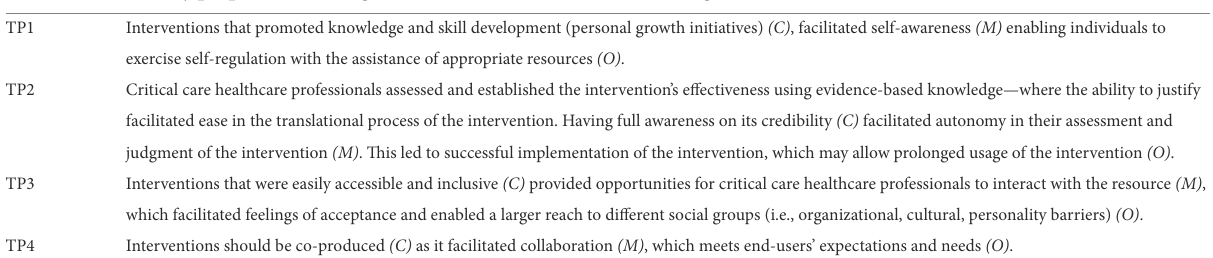
TABLE 2 Theory preposition (TP) using context-mechanism-outcome configuration (CMOC). Identifier Theory prepositions using context-mechanism-outcome